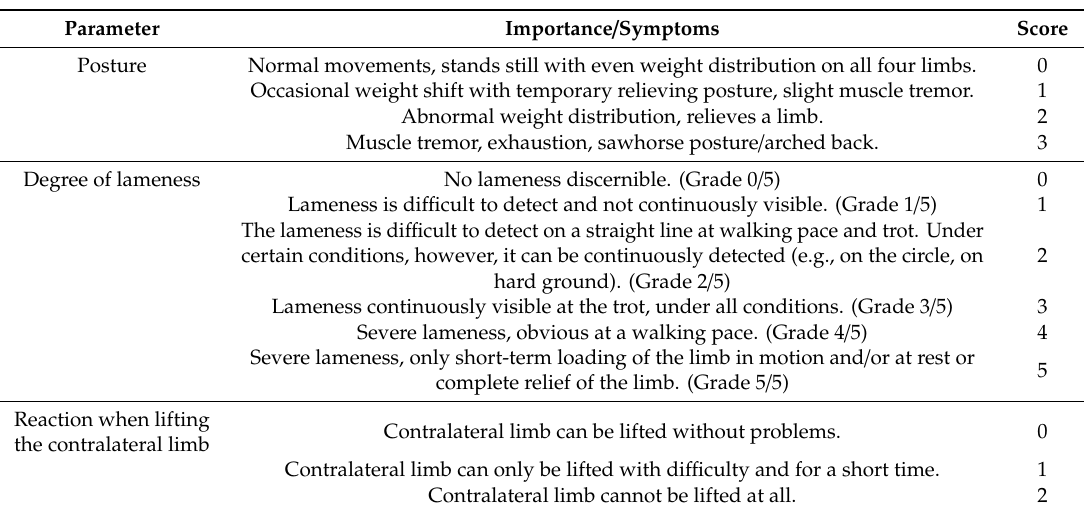
Table 4. Pain scale to determine the intensity of the pain. Additional parameters for horses with an orthopedic